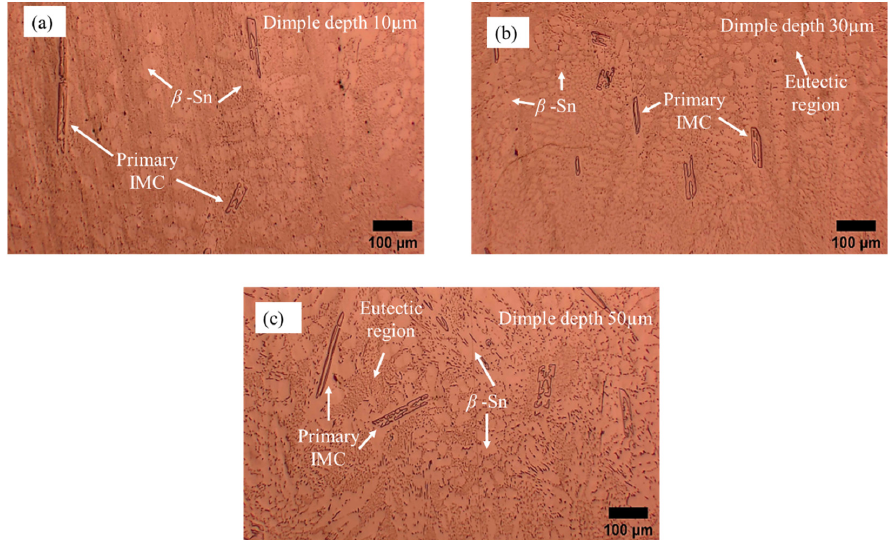
Figure 7. Microstructure analysis of Sn-0.7Cu solder for bulk microstructure on a microtextured copper substrate with dimple depth of ( a ) 10 µm, ( b ) 30 µm, and ( c ) 50 µm. Figure 8 shows the micrograph of the interfacial IMC layer of the Sn-0.7Cu solder on